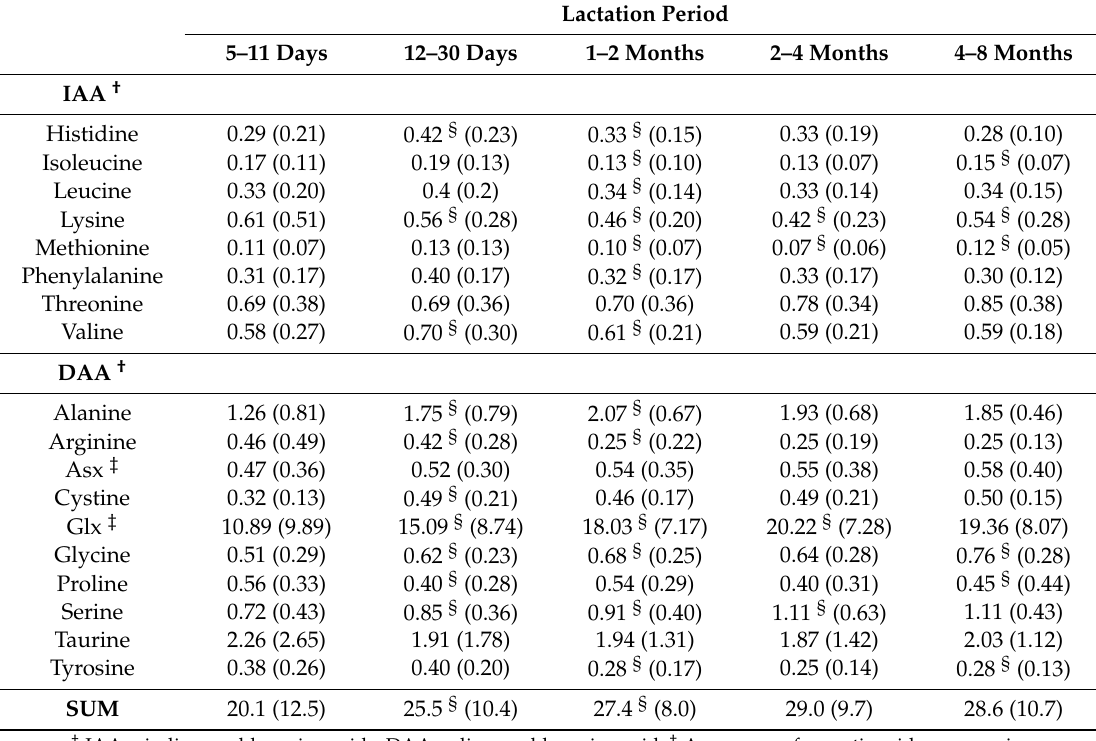
Table 3. Free AA content (mg/100 g) of milk from the different lactation